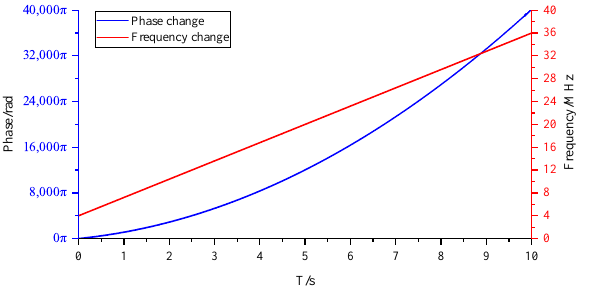
Figure 14. The phase of the quadrature signal whose frequency varies from 4 to 36 MHz after passing through the dynamic